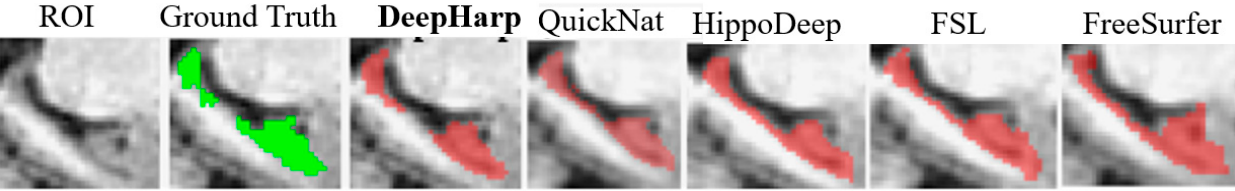
Figure 6. Comparison of segmentations for different tools for a selected patient and slice. It can be seen that Freesurfer and FSL show more false positives than other tools at the head of hippocampus. Freesurfer also has more false negatives at the tail than other tools. Table 2. Accuracy and precision of the DeepHarp method compared to other methods: the metric is the Dice coefficient. The bold numbers are showing highest Dice scores. DeepHarp has highest Dice score in accuracy and HippoDeep has highest Dice score in